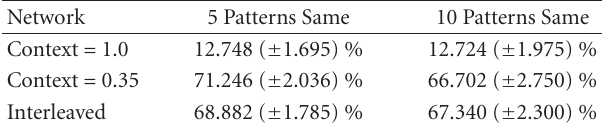
Table 3: Mean and standard error of percentage of common units for the common subtask between Base Task and the interfering task. The first row gives the ratio for a Leabra network with contextual cues of strength 1.0, the second row for a Leabra network with contextual cues of strength 0.35, and the third row for a Leabra network trained in an interleaved manner for the two tasks.